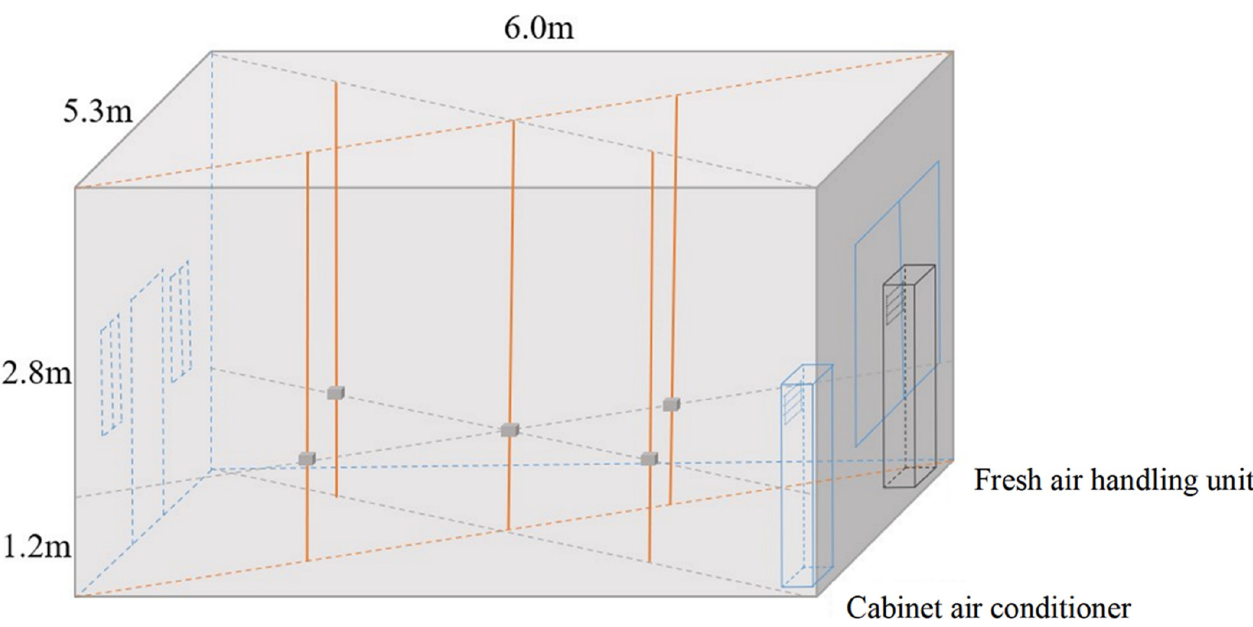
Fig 2. Experimental platform and monitoring points.